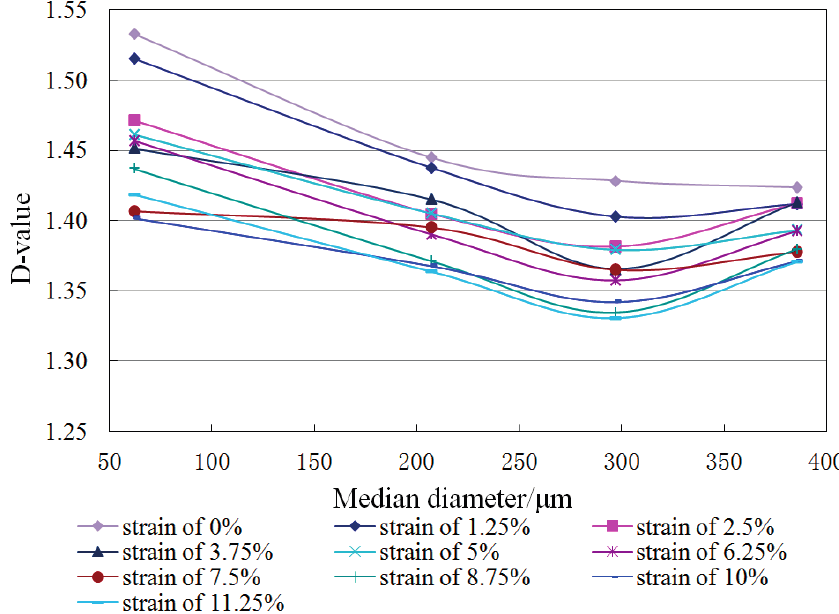
Figure 10. D -values for different